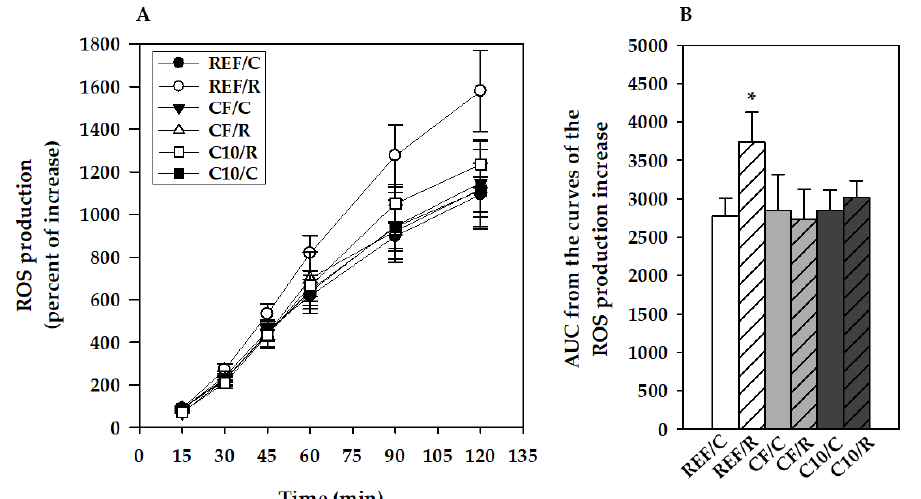
Figure 5. Reactive oxygen species (ROS) production by peritoneal macrophages 16 h after performing the final exhausion test. ( A ) Kynetics of ROS production for 2 h; ( B ) Area under the curve (AUC) between 15–120 min. REF, reference diet; CF, 5% cocoa fiber-enriched diet; C10, 10% cocoa-enriched diet; C, control groups; R, runner groups. Data are expressed as mean ± SEM (n = 8). Statistical differences (a Kruskal–Wallis test followed by a Mann–Whitney U test): * p < 0.05 vs. the C group in the same diet.